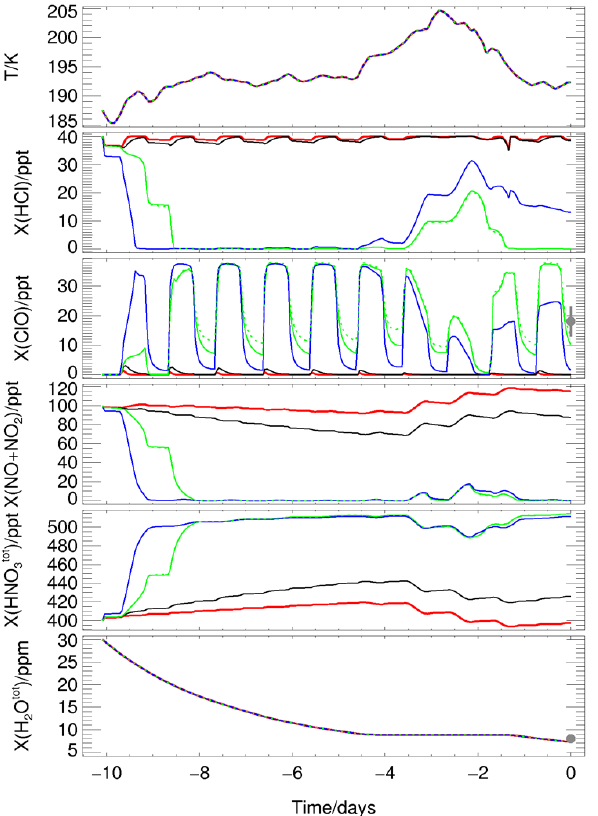
Fig. 9. As Fig. 8 but for the flight on 30 November 2005 with the trajectory ending on the flight path at 14:06UTC. The dotted lines show simulations with different rate constants for the ClO/ClOOCl reaction (see text for details). The observed x (O 3 ) was ∼